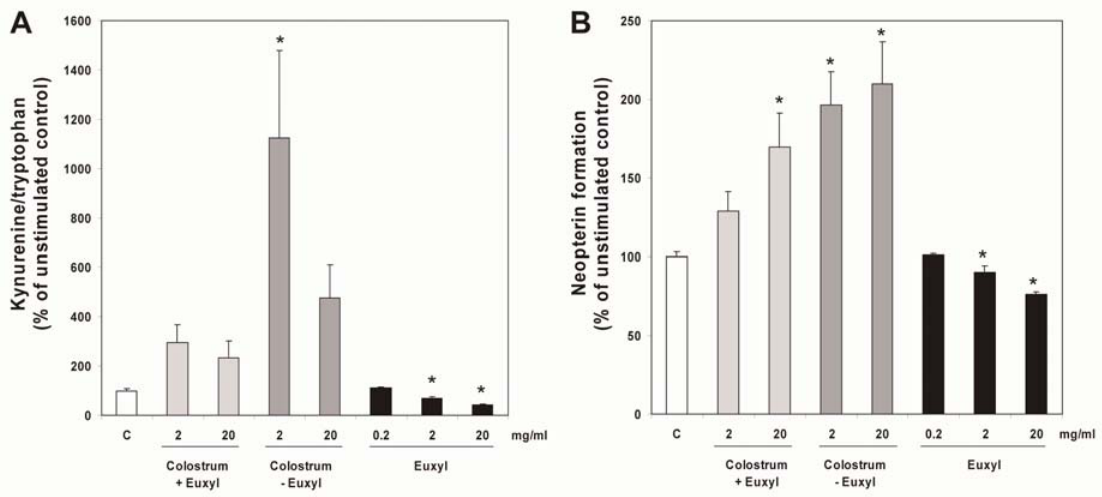
Figure 2 : Kynurenine to tryptophan ratio (left) and neopterin formation (right) expressed as % of unstimulated control in human peripheral blood mononuclear cells treated or not with increasing concentrations of bovine colostrum nanoparticles containing hyaluronic acid with or without preservative euxyl and euxyl alone for 48h. Results shown are the mean values ± S.E.M. of three independent experiments run in duplicates (*p <